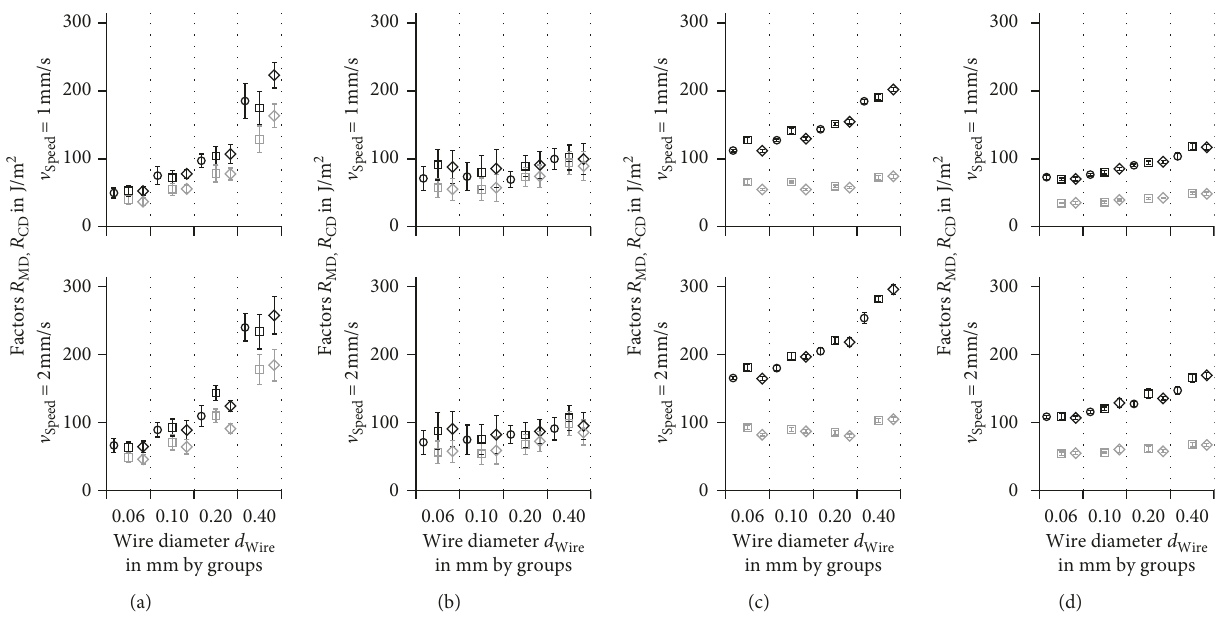
Figure 10: Plot of the factors of the regression R MD , R CD in relation to the wire diameters d Wire . The values for R MD are shown in black and for R CD in grey. The circles represent λ � 0 ° , rectangles for λ � 30 ° , and rhombus for λ � 45 ° . The error bars represent the standard deviation of measurements. (a) Edam Cheese. (b) Leberk¨ase. (c) Bubble gum 1. (d) Bubble gum